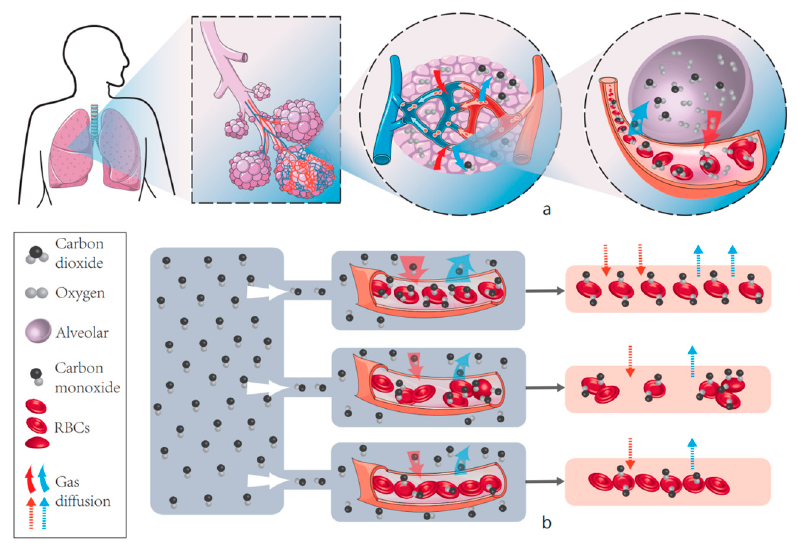
Figure 9. Pulmonary gas diffusion process and CO diffusion capacity of red blood cells under dif- ferent aggregation states. ( a ) shows the natural diffusion process of CO2 and O2 carried by red blood cells in the lungs of human body. ( b ) shows our experimental results, that is, the effect of RBCs on the amount of gas diffusion in different aggregation and deformation states, it can be clearly con- cluded that the diffusion capacity of CO decreases when RBCs deform, and it can also be shown that RBCs in the aggregated state have significantly lower diffusion capacity.